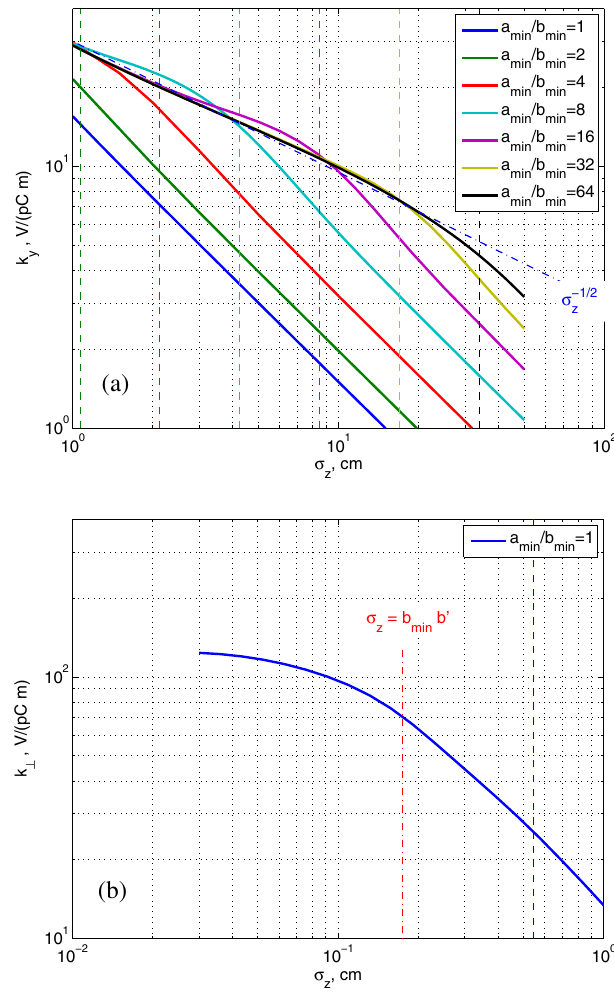
FIG. 10. (Color) (a) Vertical-dipolar kick factor vs bunch length derived from GDFIDL wake potentials due to a 1 cm rms bunch (solid line). Threshold values of bunch length from Eq. (2.17) (color dashed line). (b) Transverse kick factor vs bunch length derived from ABCI wake potentials due to a 0.3 mm rms bunch in the axially symmetric structure (solid line). Bunch length from Eq. (2.17) (blue dashed